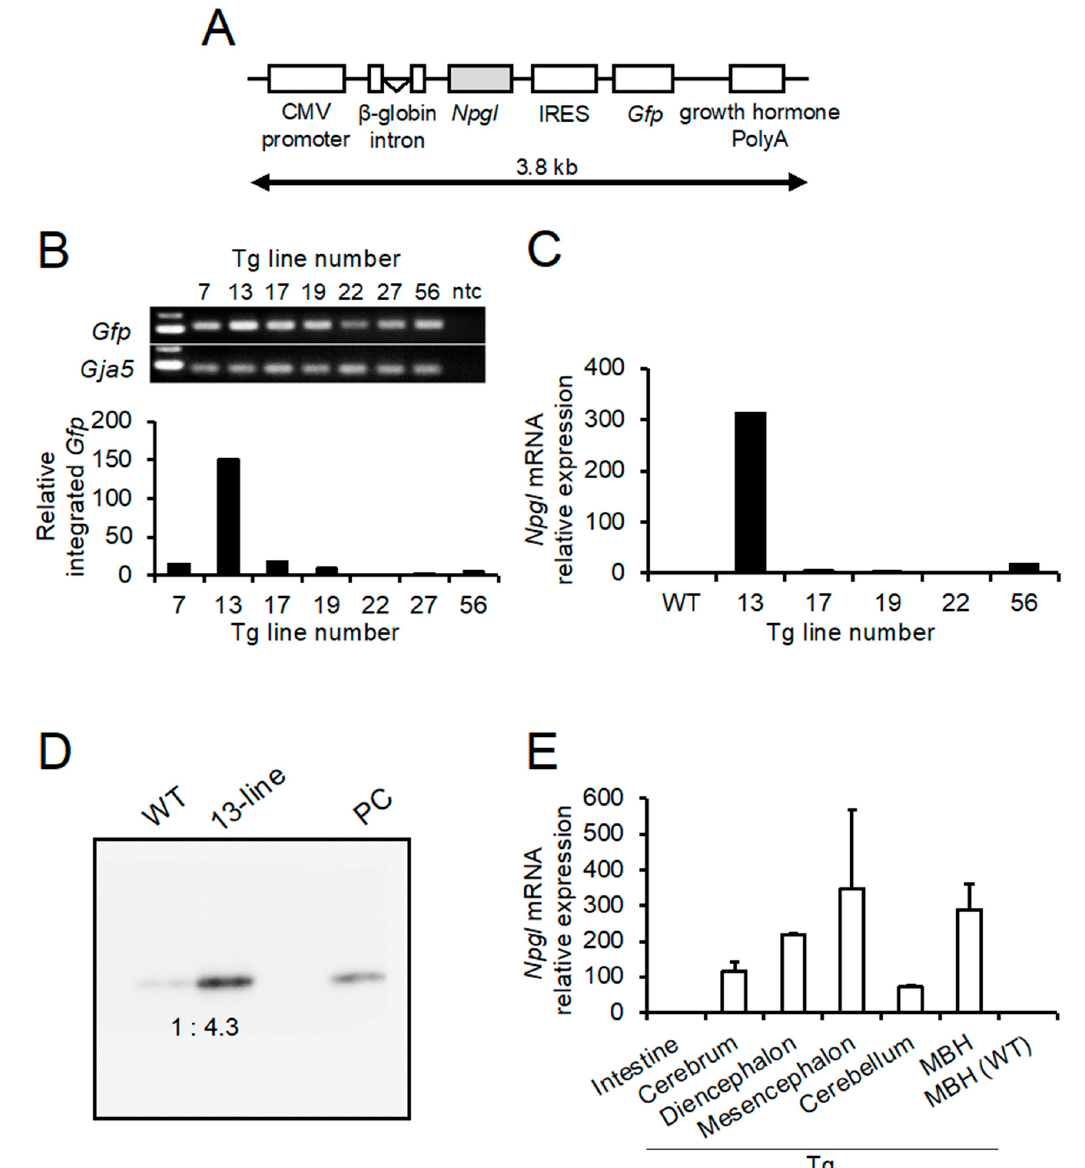
Figure 1. Generation of Npgl Tg mice and line selection using phenotypic analysis. ( A ) Structure of the 3.8 kb transgene integrated into the genomic DNA of Npgl Tg mice. Npgl is under the control of the ubiquitous CMV promoter. IRES enables co-expression of Gfp with Npgl . The β -globin intron was inserted between the CMV promoter and Npgl . ( B ) Genomic DNA analysis (top) and quantification of integrated Gfp using qRT-PCR (bottom). Genomic DNA analysis revealed that the transgene was integrated into seven F0 mice. The numbers of transgenic mice were 7, 13, 17, 19, 22, 27, and 56. Gja5 was used as an internal standard. ntc indicates no-template control. qRT-PCR showed that the transgene was most integrated into mouse number 13. ( C ) qRT-PCR analysis of NPGL precursor mRNA expression in the mediobasal hypothalamus of the WT and Npgl Tg mice. ( D ) Western blot analysis of mature NPGL in the mediobasal hypothalamus of the WT and Npgl Tg mice. Synthesized NPGL was used as the positive control (PC). ( E ) qRT-PCR analysis of NPGL precursor mRNA concentrations in different brain regions and intestines of Npgl Tg mice and in the MBH of WT mice. The NPGL precursor mRNA levels were quantified relative to the level of Actb mRNA. Each value represents the mean ± SEM ( n = 2). Npgl , neurosecretory protein GL; CMV, cytomegalovirus; IRES, internal ribosome entry sites; Gfp , green fluorescent protein; Gja5 , gap junction alpha 5; WT, wild-type; Tg, transgenic; MBH, mediobasal hypothalamus; Actb , β -actin.